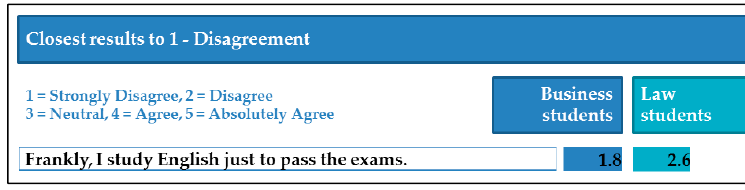
Figure 3. Business students’ expectations towards the skills to develop in their ESP course.